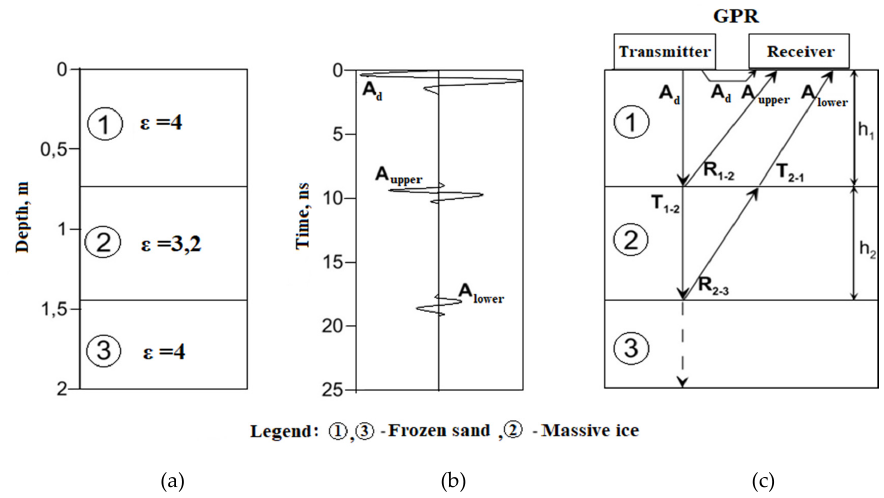
Figure 1. Ground-penetrating radar (GPR) model of frozen rock mass with massive ice ( a , b ) and a schematic diagram of the formation of reflected electromagnetic waves ( c ).